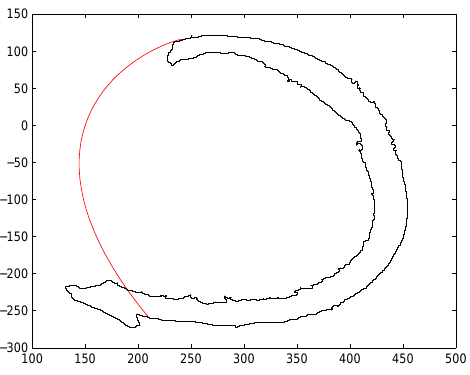
Figure 17. Construction of fractured part curve using GC 1 rational Ball curves with one